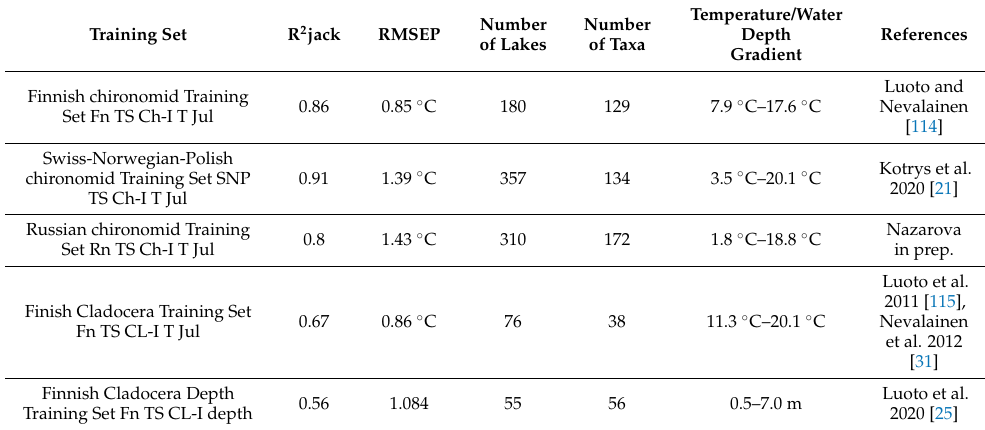
Table 1. Training sets used in the analysis and their